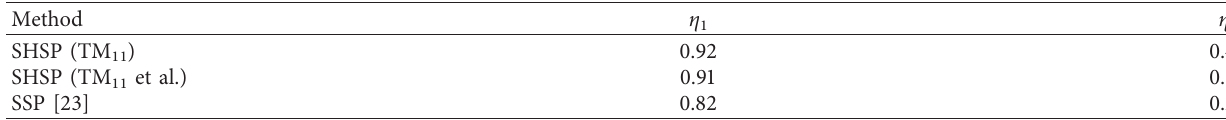
Table 4: Parameters η